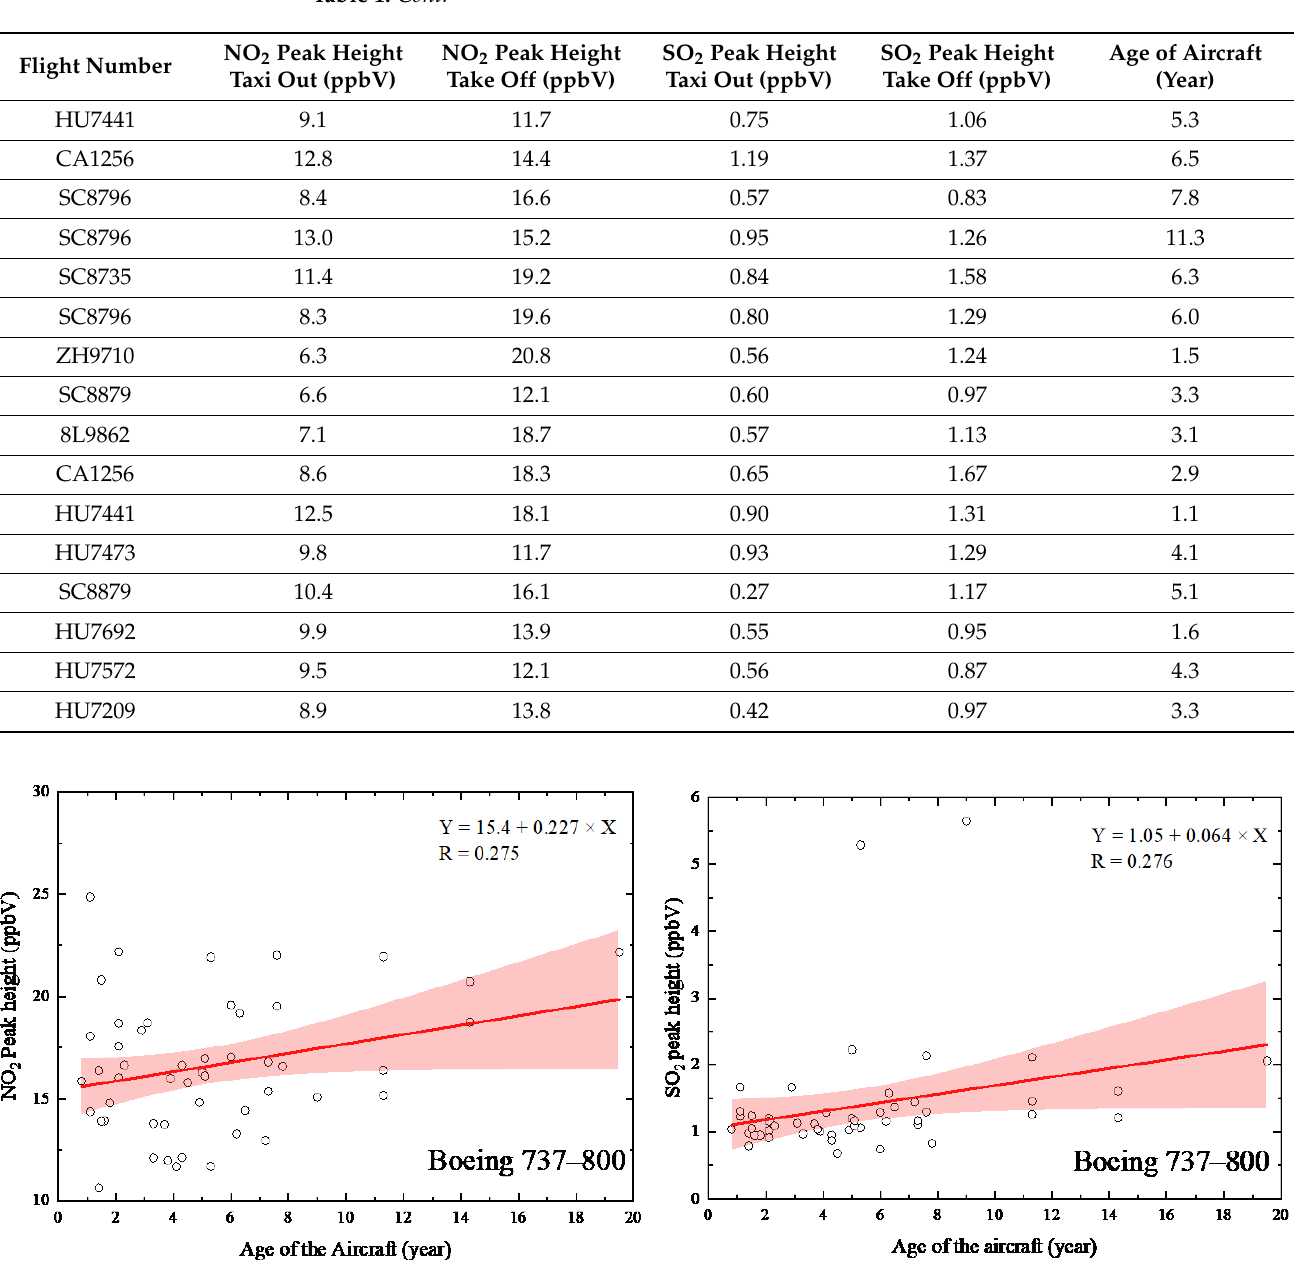
Figure 7. Linear dependence of the measured NO 2 and SO 2 peak heights on the aircraft age for 737–800 aircraft.